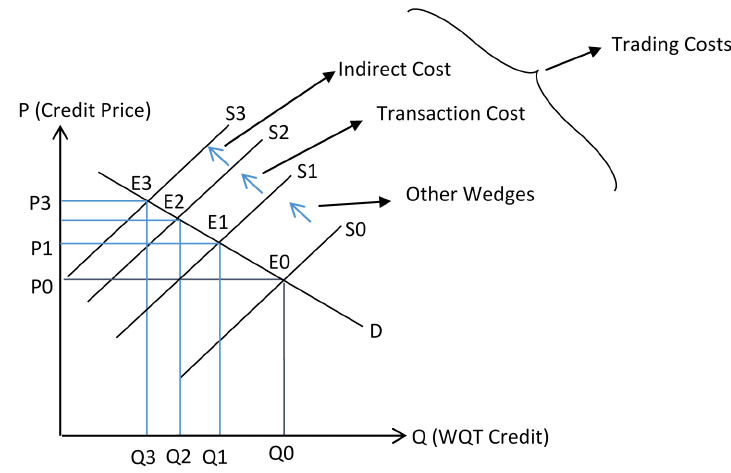
Figure 1. Role of indirect cost on adoption premium in water quality trading market.